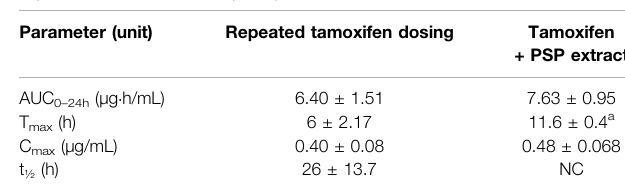
TABLE 2 | Non-compartmental pharmacokinetic parameters of repeated tamoxifen oral dosing (20 mg/kg for 12 days) with/without PSP